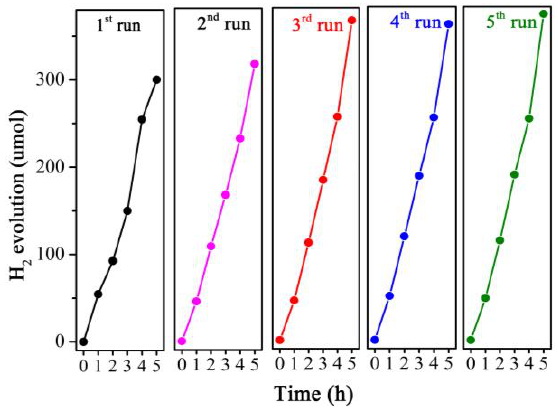
Figure 7. Stability of Ag-I-RuO 2 -O-THS during prolonged photocatalytic operation.